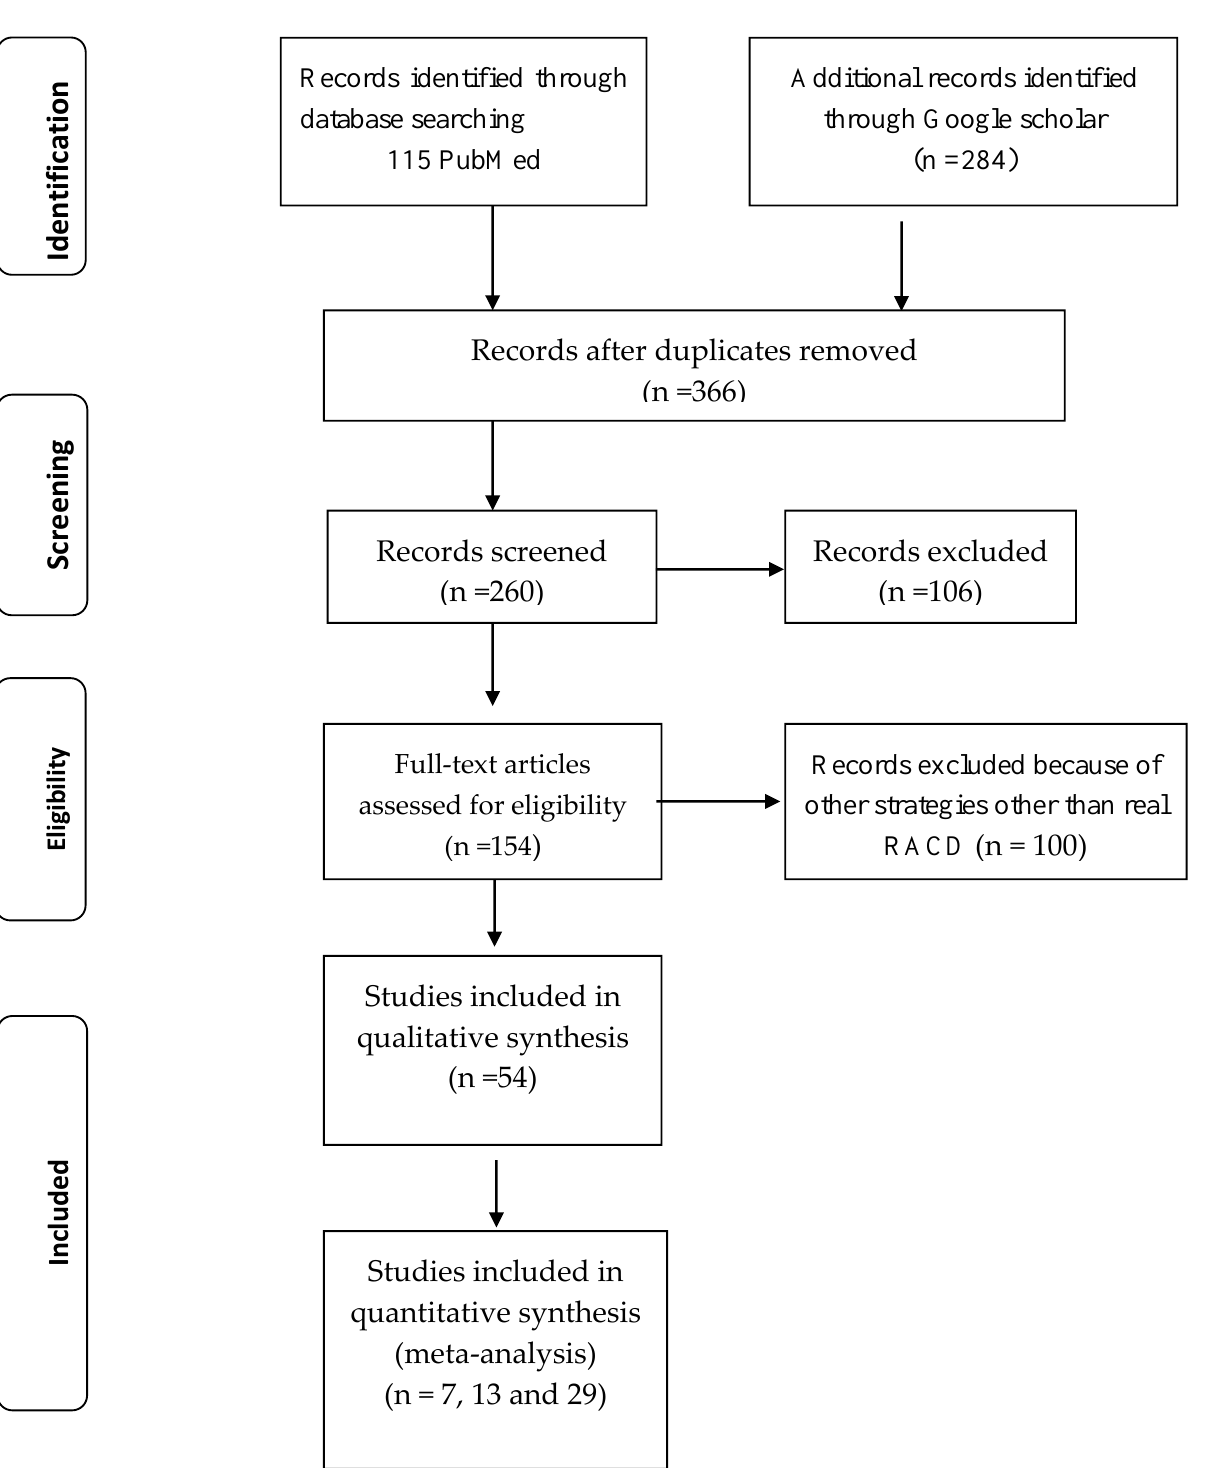
Figure 1. PRISMA flow diagram showing schematic illustration of database searches, identification, screening, and eligibility of included studies.